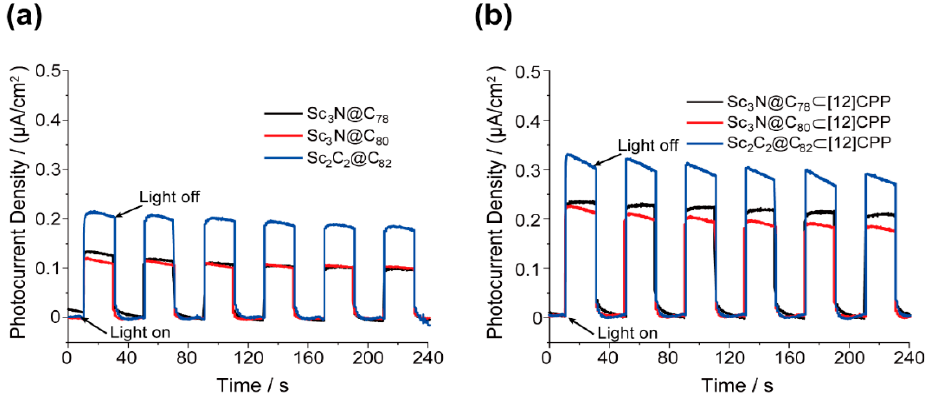
Figure 2. ( a ) Photocurrent responses of spin coating films of Sc 3 N@C 78 , Sc 3 N@C 80 , and Sc 2 C 2 @C 82 . ( b